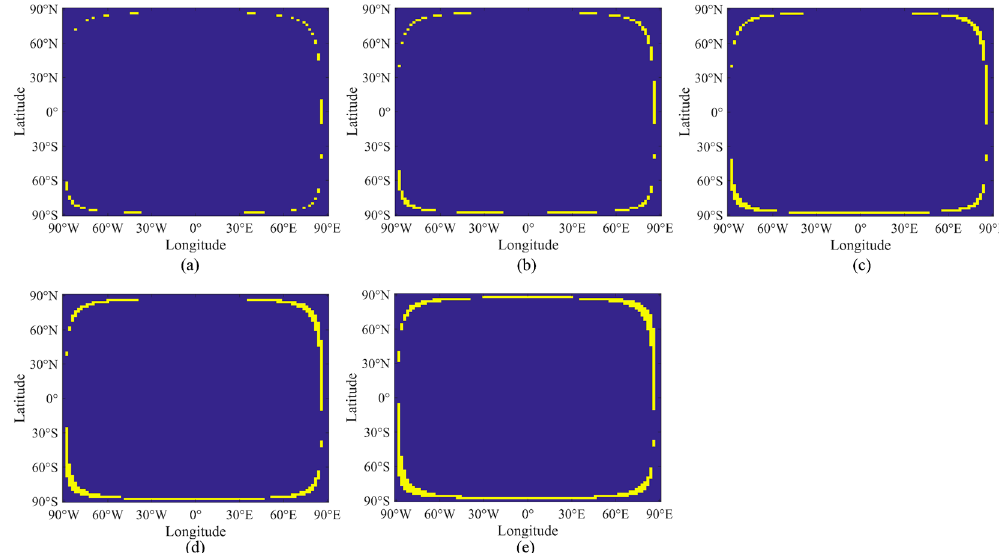
Figure 10. Area differences on the Moon between ( a ) 00:00 and 04:00, ( b ) 00:00 and 08:00, ( c ) 00:00 and 12:00, ( d ) 00:00 and 16:00, and ( e ) 00:00 and 20:00 UTC on 1 January 2010.